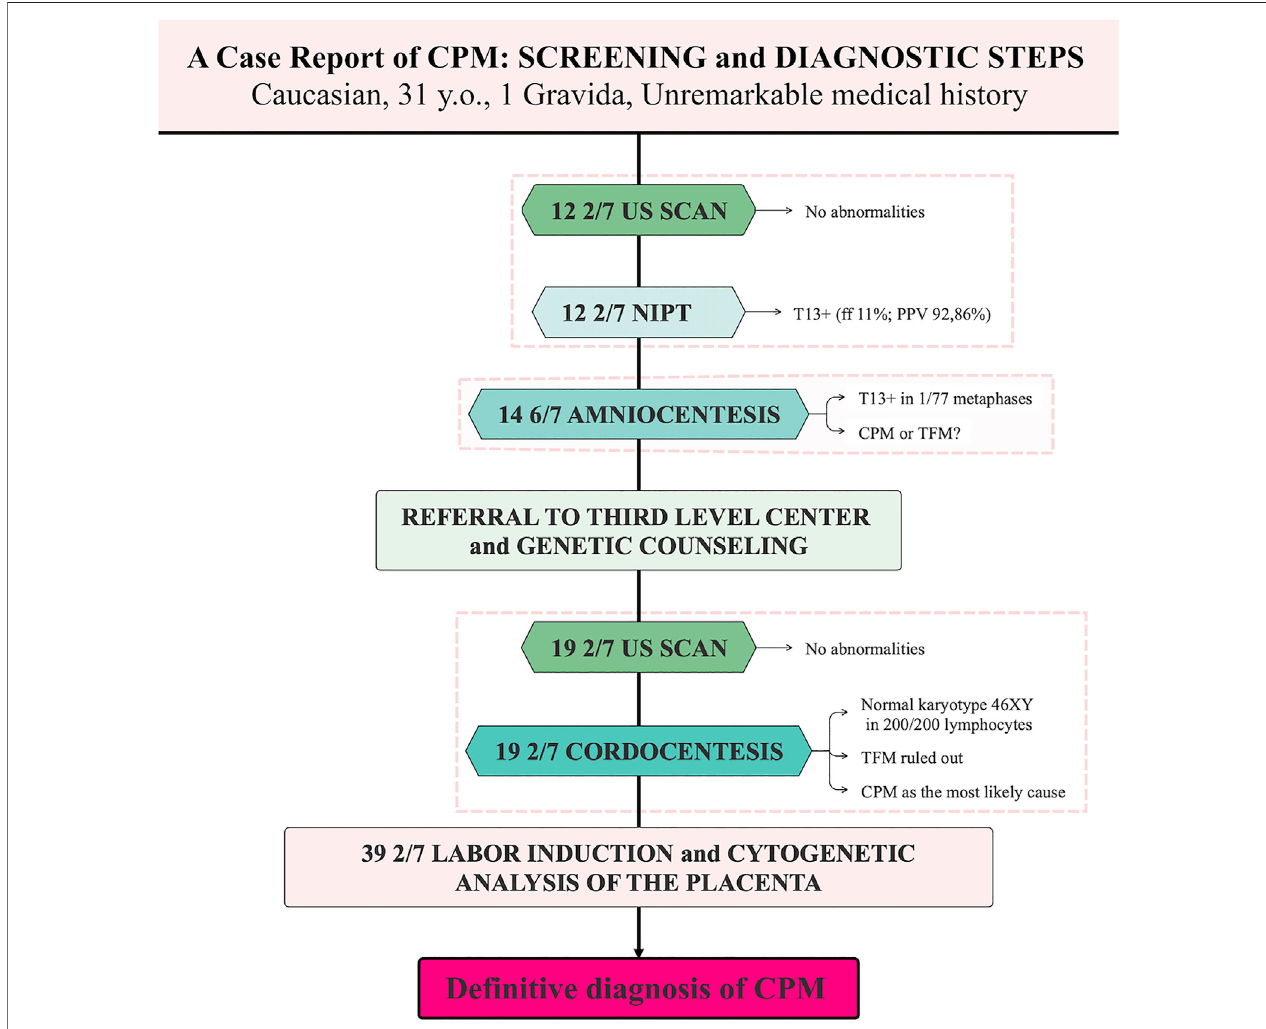
FIGURE 1 | Screening and diagnostic steps in a case of Con fi ned Placental Mosaicism. CPM, Con fi ned Placental Mosaicism; TFM, True Fetal Mosaicism; ff, Fetal Fraction; PPV, Positive Predictive Value.